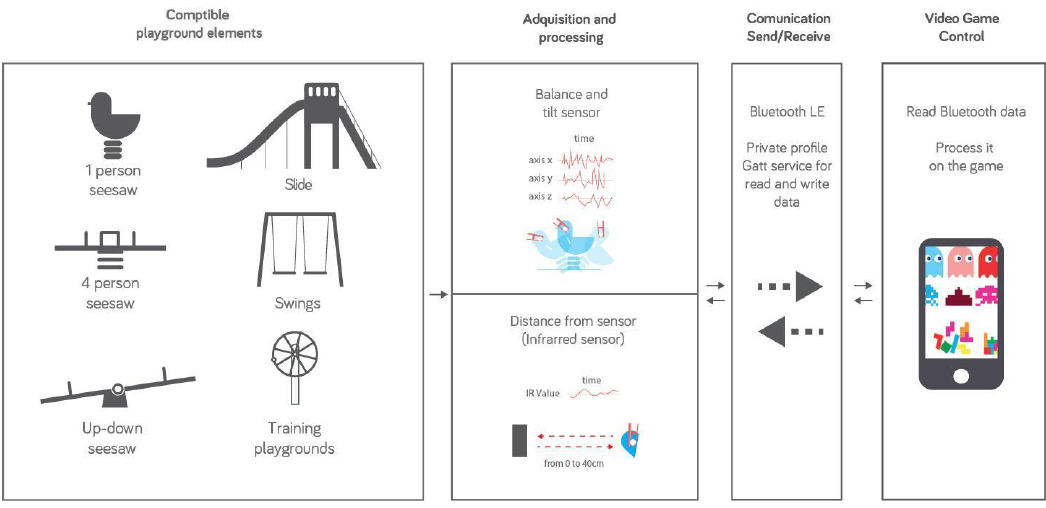
Figure 1. HybridPLAY workflow.